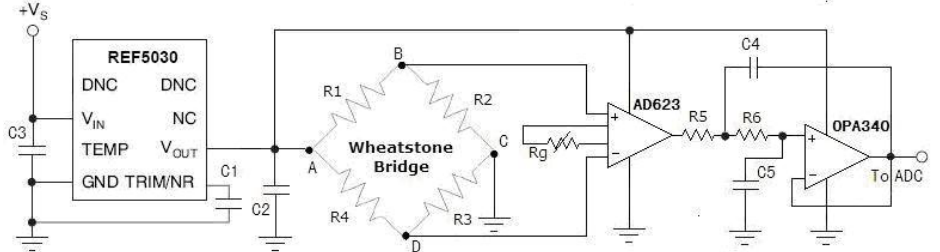
Shock-proof Slot Design